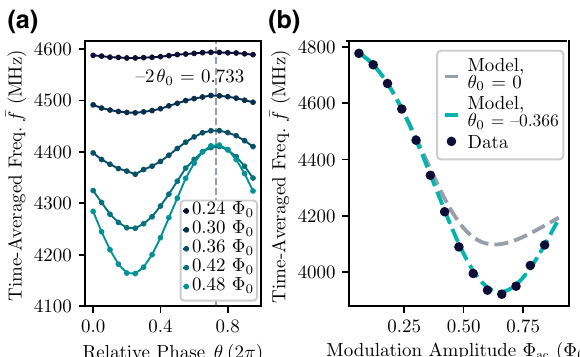
FIG. 10. (a) Measurement of θ 0 for qubit 3. For bichromatic modulation of constant p , α , and amplitude (cid:2) ac , time-averaged ¯ qubit frequency f is sinusoidal in θ + ( 1 − p )θ 0 . The phase off- ¯ set of the fitted f oscillation in θ can thus be mapped to θ 0 . While one (cid:2) ac is sufficient to measure this offset, the fit value here is the median of offsets measured at five different modula- tion amplitudes. (b) For the same qubit, measured detuning under